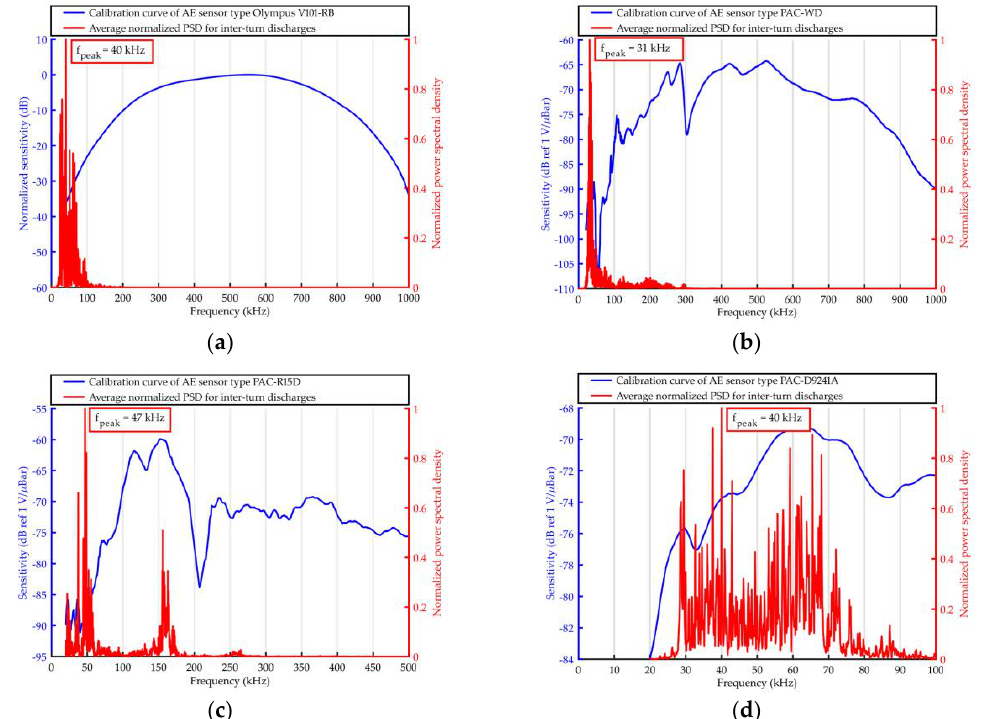
Figure 13. Average normalized PSD determined for AE signals emitted by interturn discharges and registered with the use of ultrasonic sensor type: ( a ) Olympus V101-RB, ( b ) PAC WD, ( c ) PAC R15D, and ( d ) PAC D9241A.